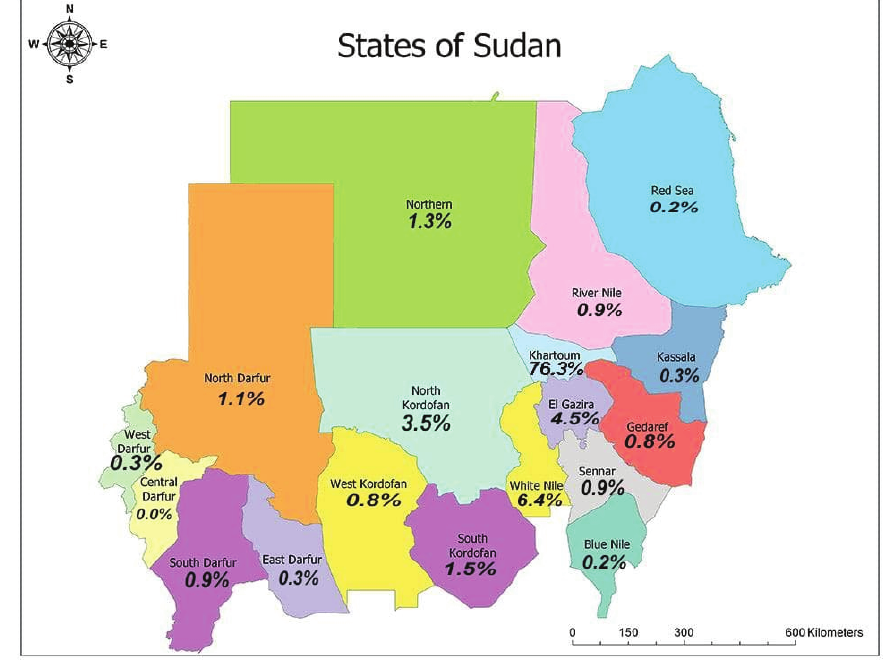
Figure 1 : Distribution of thyroid diseases in